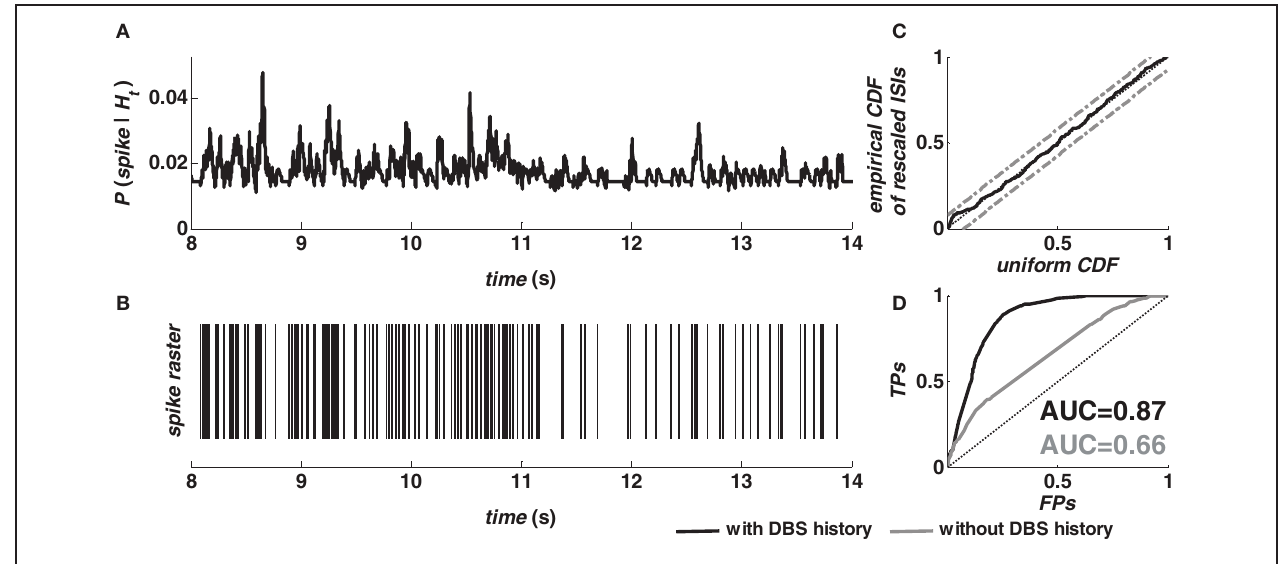
(C) Kolmogorov-Smirnov (KS) plot after time rescaling of the estimated model on the validation data. Grey lines are 95% confidence bounds. (D) ROC curve for the target neuron (TP = true-positive; FP = false-positive) on validation data. The color code in the legend also applies to the AUC values.